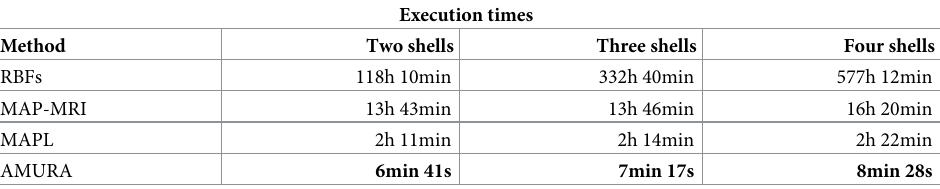
Table 8. Estimated execution times for the calculation of the measures with different methods. One single volume (HCP MGH 1016) is